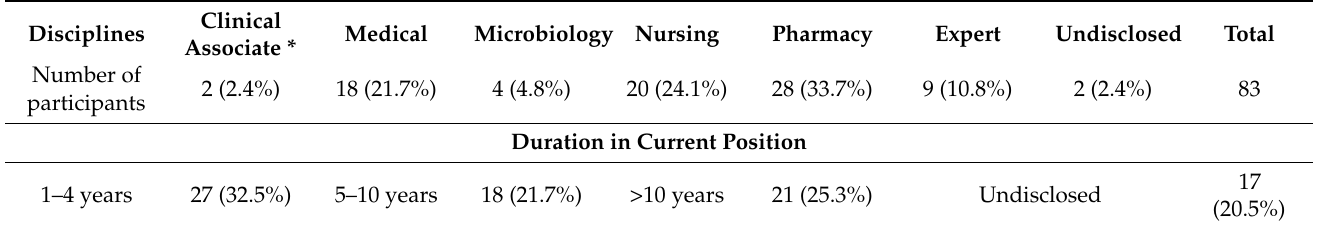
Table 2. Disciplines represented and duration in current position ( n =